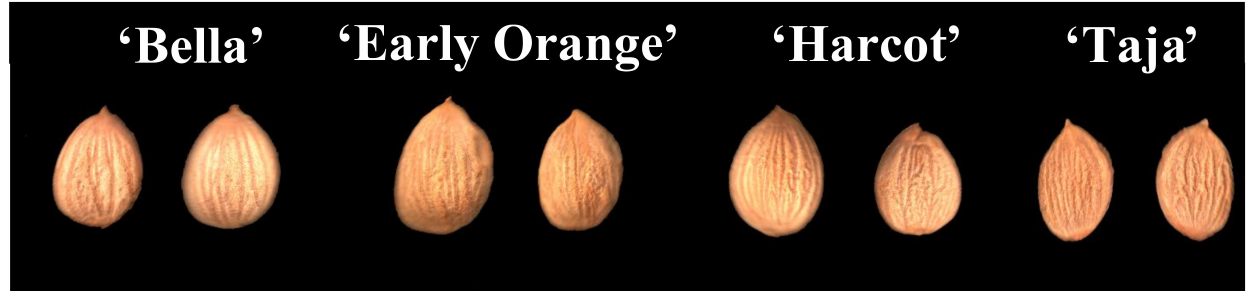
Figure 1. Images of apricot seeds belonging to different